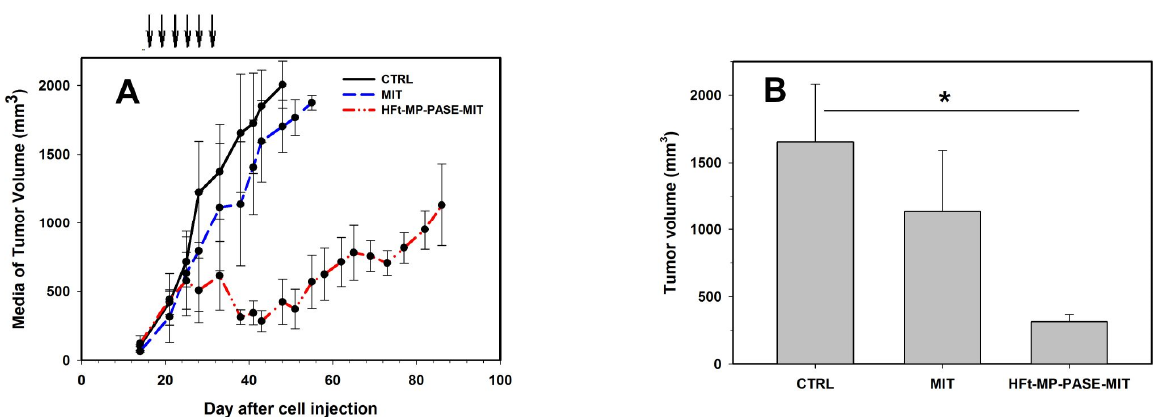
Figure 3. ( A ) Growth curves representing the media of the tumor volume for each of the treated groups: HFt-MP-PASE-MIT, MIT or saline (CTRL, control); n = 4. Arrows indicate the six days of treatment administration. ( B ) Tumor volume of the three different groups measured at day 38 after tumor cell injection. * p < 0.05.